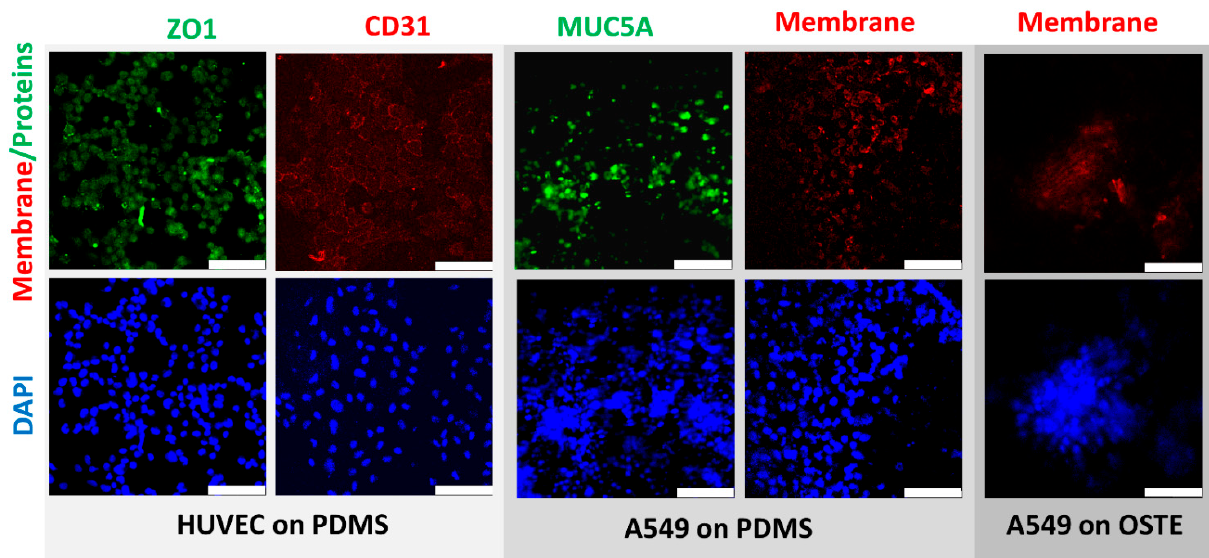
Figure 4. Comparison of confocal microscopy pictures of human umbilical vascular endothelial cells (HUVEC) and A549 cells between PDMS and OSTE LOACs. Blue color represents DAPI-stained cell nucleus. CD31 antibody stained with APC and CellVue are represented as red color. ZO1 and MUC5A stained with FITC are represented in green color. White scale bar represents 100 µm.